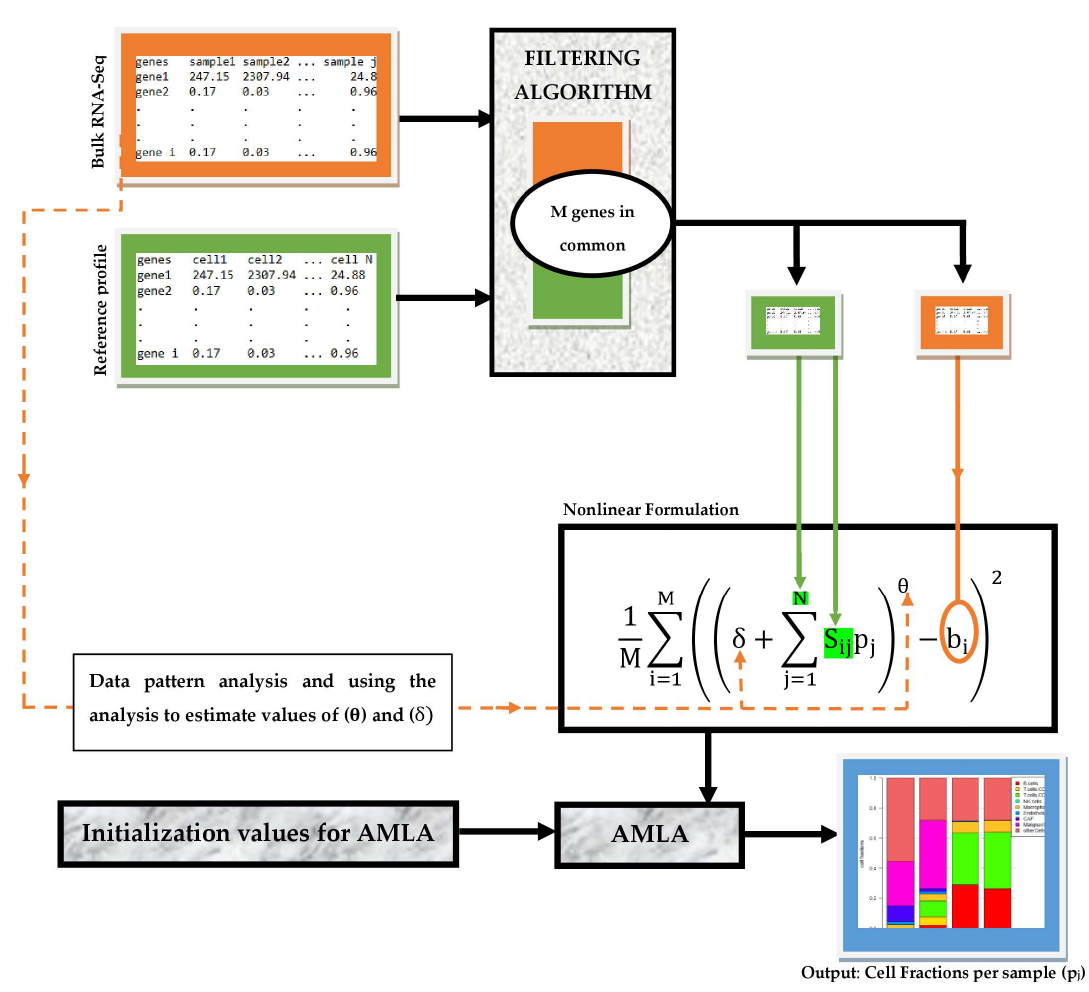
Figure 1. Workflow for the deconvolution of TIICs using a nonlinear optimization framework .